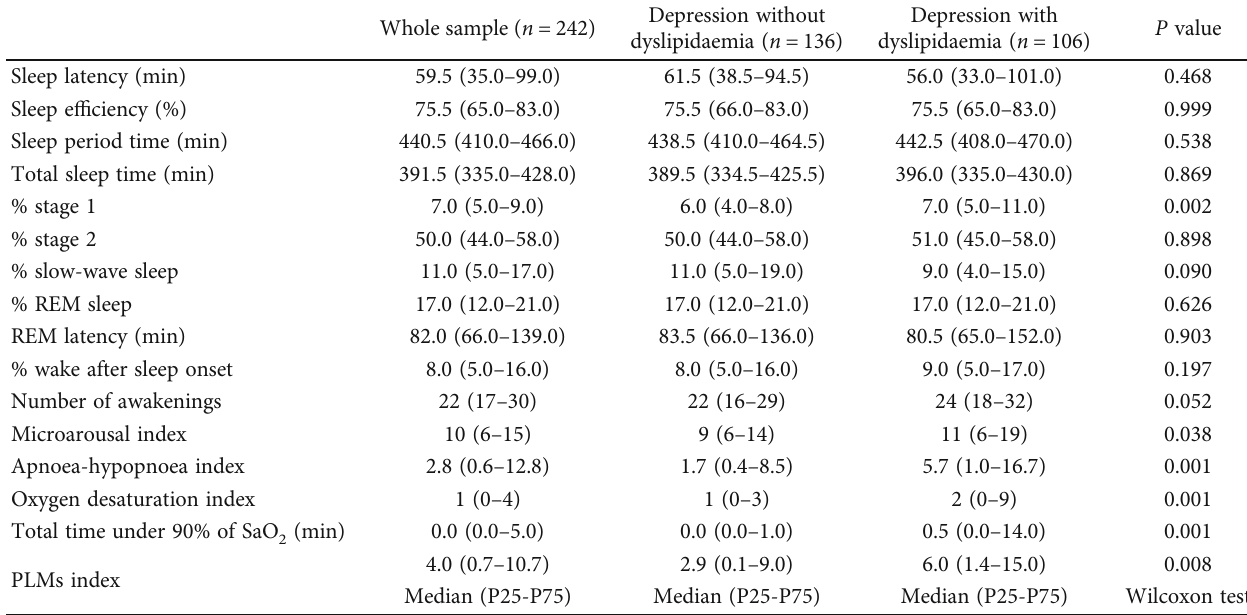
Table 1: Polysomnographic data ( n = 242